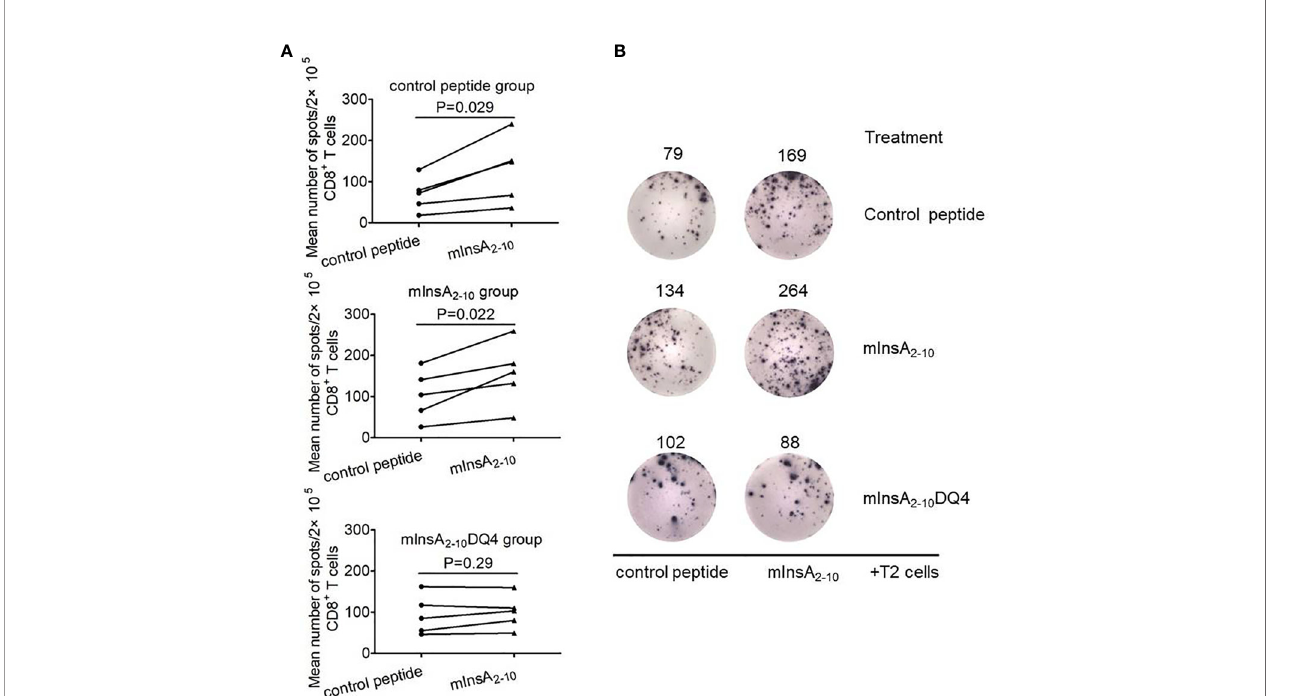
FIGURE 5 | mInsA 2-10 DQ4 treatment resulted in loss of mInsA 2-10 autoreactive CD8 + T cell responses. (A) Statistical analysis of the average number of control peptide or mInsA 2-10 -speci fi c IFN- g -positive spots per 2×10 5 splenic CD8 + T cells in triplicate cultures with a treatment group (n = 5) are shown. Signi fi cance was determined by a paired t -test. (B) Representative IFN- g ELISPOT assay demonstrated splenic CD8 + T cell responses to T2 cell loaded with mInsA 2-10 in each peptide-treated group of non-diabetic NOD. b 2 m null .HHD mice at 12 weeks of